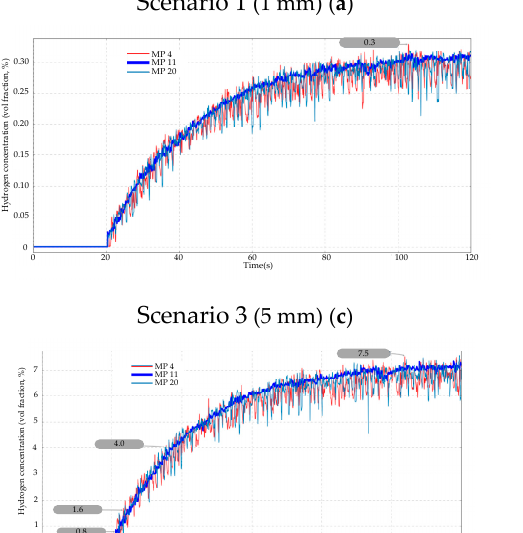
Figure 11. Hydrogen concentration at MP11 for different leak diameters. The hydrogen concentration trend in the FCR is consistent regardless of the leakage diameter, as shown in Figure 10. The maximum hydrogen concentration in the FCR de- creased with decreasing leakage diameter, as seen in Figure 11. MP4 and MP20 show fluc- tuating hydrogen concentrations due to their proximity to the air inlet, which is affected by wind speed (the speed of the air inlet on this vessel is about 6.9 m/s). The maximum hydrogen concentration of scenarios 1 and 2 is below the hydrogen LFL (4.0%), indicating that FGC explosion accidents will not occur if leaking hydrogen is not immediately ignited. FGC explosion is impossible in the FCR when there is single- point leakage in the hydrogen pipeline with an inner diameter not exceeding 3 mm. Ef- fective mechanical ventilation systems of the extraction type and choosing a small enough inner diameter of the hydrogen pipelines can prevent FGC explosion in the FCR, but they are limited by engineering practicality.